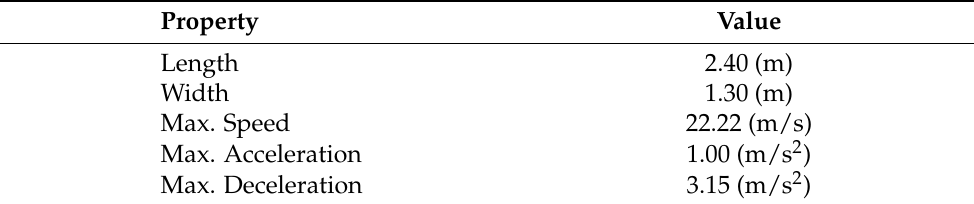
Table 1. Twizy general